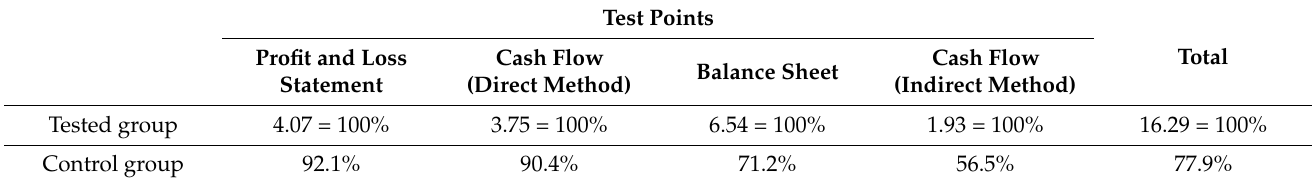
Table 2. Relative comparison of the achievements.